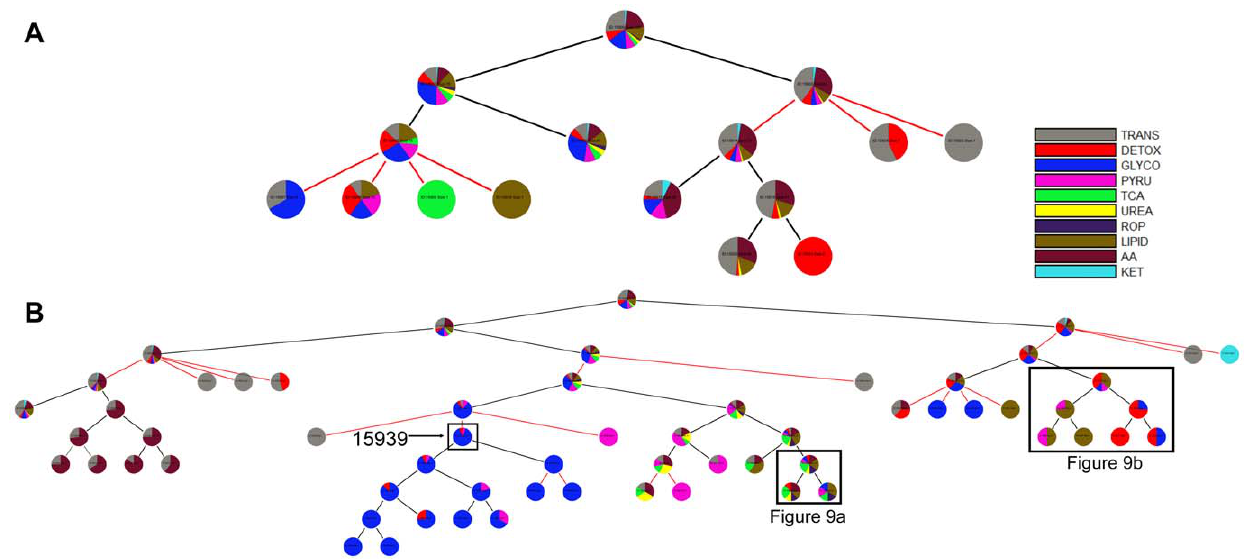
Figure 5. Hierarchical partitions of hepatocyte metabolic network. (A) Partitions obtained using Newman’s connectivity metric. (B) Partitions obtained using the ShReD. Details of the reactions in the boxed modules are shown in Figures 9a and 9b. The other boxed module (ID: 15939) contains pyruvate kinase.